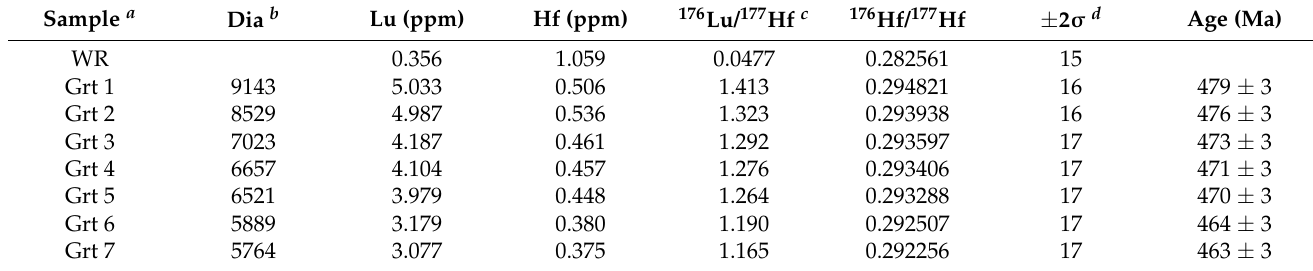
Table 5. Lu–Hf isotope data for the seven garnets and the whole rock.